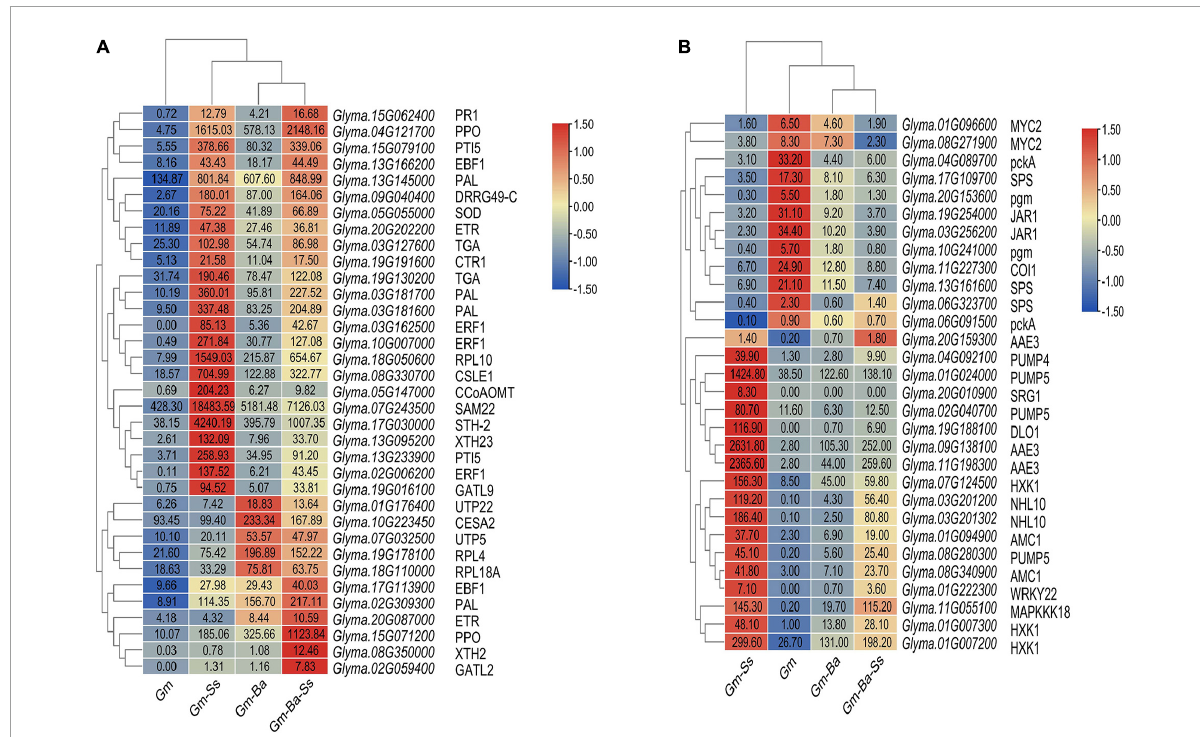
FIGURE6 Heatmaps of soybean DEGs. (A) DEGs possibly related to the improvement of soybean resistance by B. amyloliquefaciens . (B) DEGs possibly related to soybean seedling senescence by S. sclerotiorum . The number in each heatmap box represents the FPKM value of each gene. AAE3, Oxalate-CoA ligase; CCoAOMT , caffeoyl-CoA 3- O -methyltransferase; CESA2, Cellulose synthase A catalytic subunit 2; COI1, coronatine-insensitive protein 1; CSLE1 , Cellulose synthase-like protein E1; CTR1, serine/threonine-protein kinase CTR1; DLO1, DMR6-LIKE OXYGENASE 1; DRRG49-C, Disease resistance response protein DRRG49-C; EBF1, EIN3-binding F-box protein; ERF1, ethylene-responsive transcription factor 1; ETR, ethylene receptor; GATL2, galacturonosyltransferase-like 2; GATL9, galacturonosyltransferase-like 9; HXK1, Hexokinase-1; JAR1, jasmonic acid-amino synthetase; MAPKKK18, mitogen-activated protein kinase kinase kinase 18; AMC1, Metacaspase-1; MYC2, transcription factor MYC2; NHL10, NDR1/HIN1-like protein 10; PAL, phenylalanine ammonia lyase; pckA, phosphoenolpyruvate carboxykinase (ATP); pgm, phosphoglucomutase; PPO, polyphenol oxidase; PR1, pathogenesis related protein 1; PTI5, Pathogenesis-related genes transcriptional activator PTI5; PUMP, mitochondrial uncoupling protein; RPL10, ribosomal protein L10; RPL18A, ribosomal protein L18a; RPL4, ribosomal protein L4; SAM22, Stress-induced protein SAM22; SOD, Superoxide dismutase; SPS, Sucrose-phosphate synthase; SRG1, protein SRG1; STH-2,Pathogenesis-related protein STH-2; TGA, transcription factor TGA; UTP22, U3 small nucleolar RNA-associated protein 22; UTP5, U3 small nucleolar RNA-associated protein 5; WRKY22, WRKY transcription factor 22; XTH, Xyloglucan endotransglucosylase/hydrolase